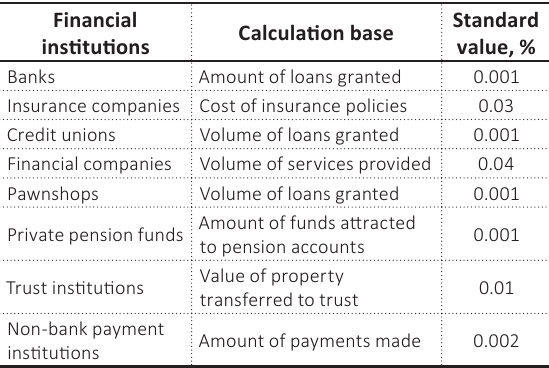
Table 3. Rates of the fixed part of